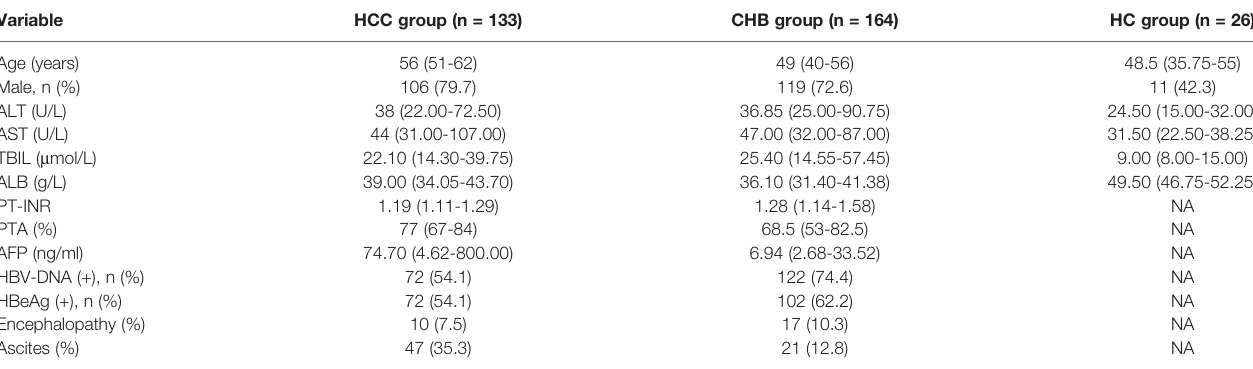
TABLE 2 | Baseline characteristics of the enrolled participants.